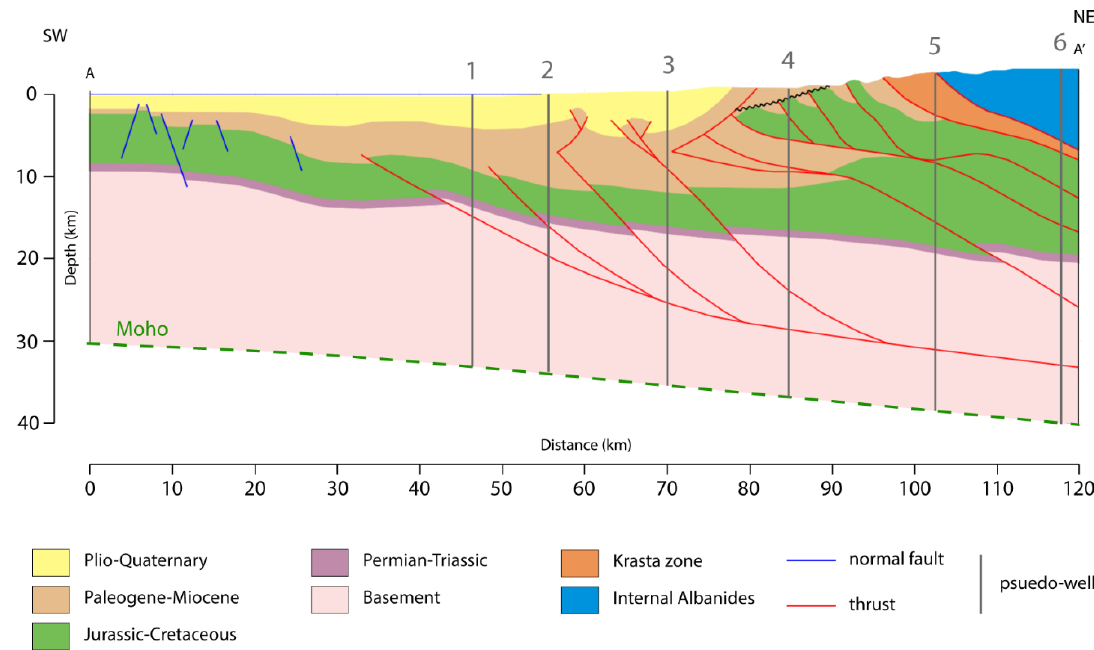
Figure 6. Model section of Figure 4 with pseudo-wells used to calculate the thermal structure.